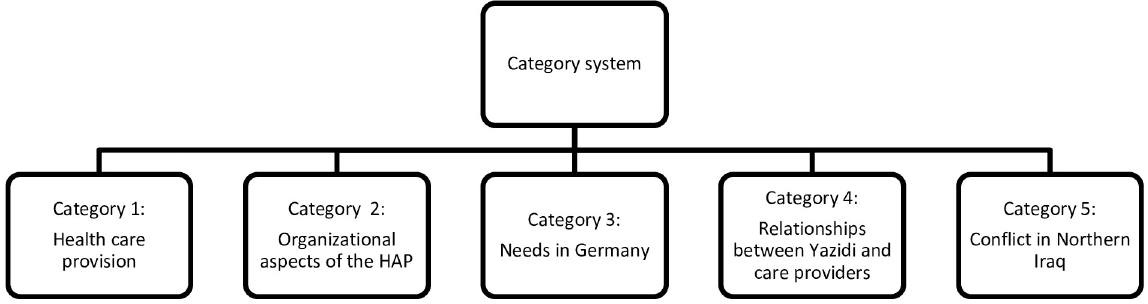
Fig 1. Code book with the main categories of the qualitative data derived from the analyses of the focus groups and single interviews with the care providers in the HAP.